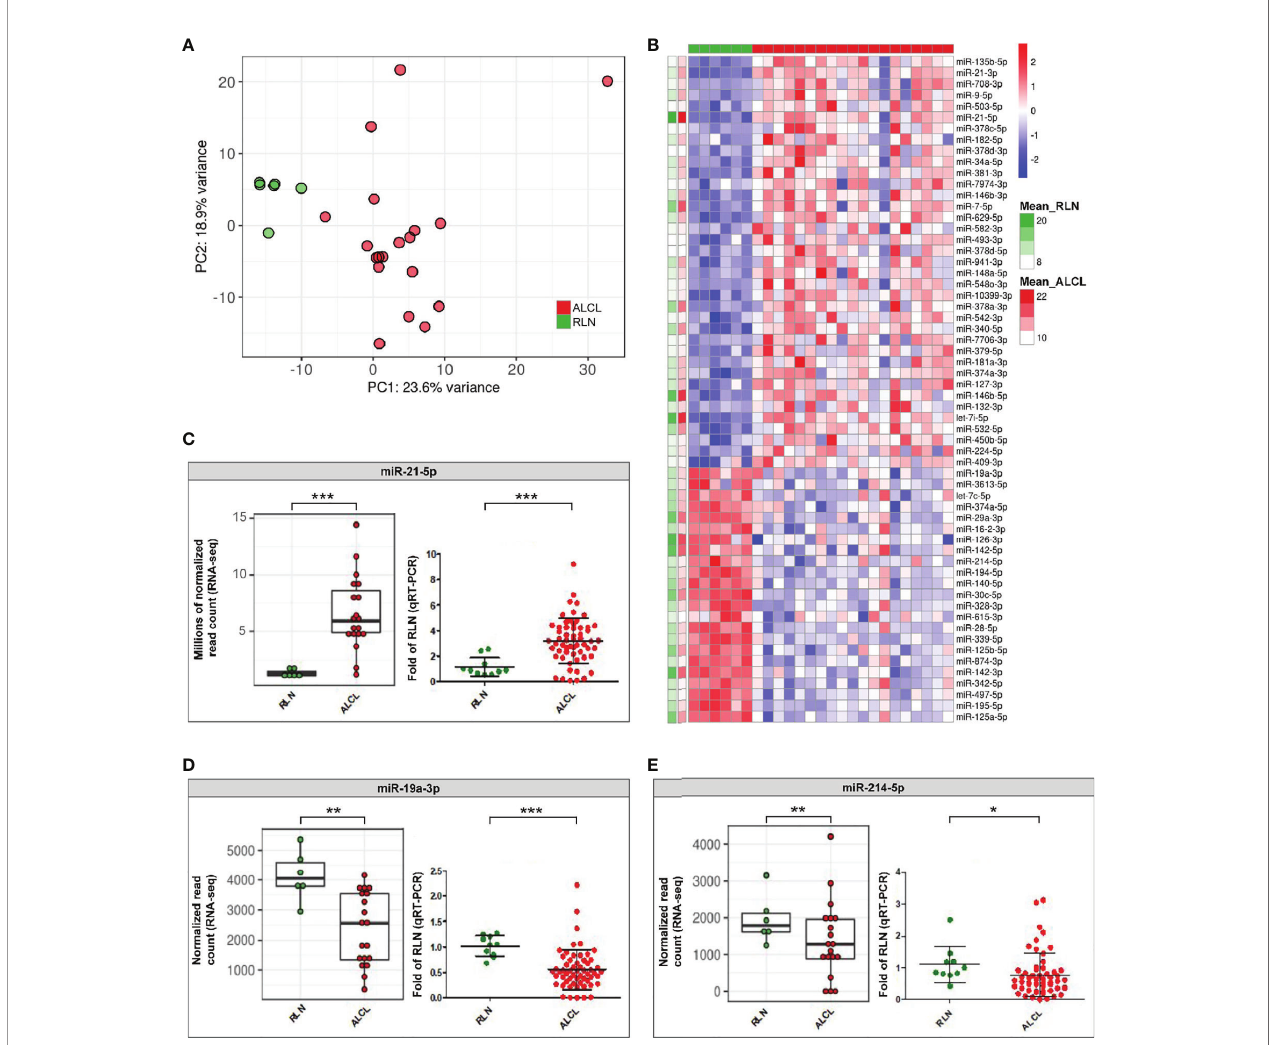
FIGURE 1 | Differentially expressed sRNAs in primary tumours of ALCL patients compared to reactive lymph nodes (RLN). (A) Unsupervised principal component analysis of sRNA expression pro fi les in ALCL (red dots) and RLN (green dots) samples. (B) Heatmap of the 60 miRNAs most dysregulated in ALCL compared with RLN (q-value ≤ 0.01 and absolute log2 Fold Change (LFC) ≥ 1; standardized expression; the two columns on the left indicate the mean expression in ALCL and RLN samples, for each miRNA); (C – E) Expression of miR-21-5p, miR-19a-3p and miR-214-5p determined by RNA-seq in the discovery cohort (left panel; ** and *** q-value < 0.01 and < 0.001) and validated by qRT-PCR in the extended cohort (right panel; * and ***, p-value < 0.05 and < 0.001;